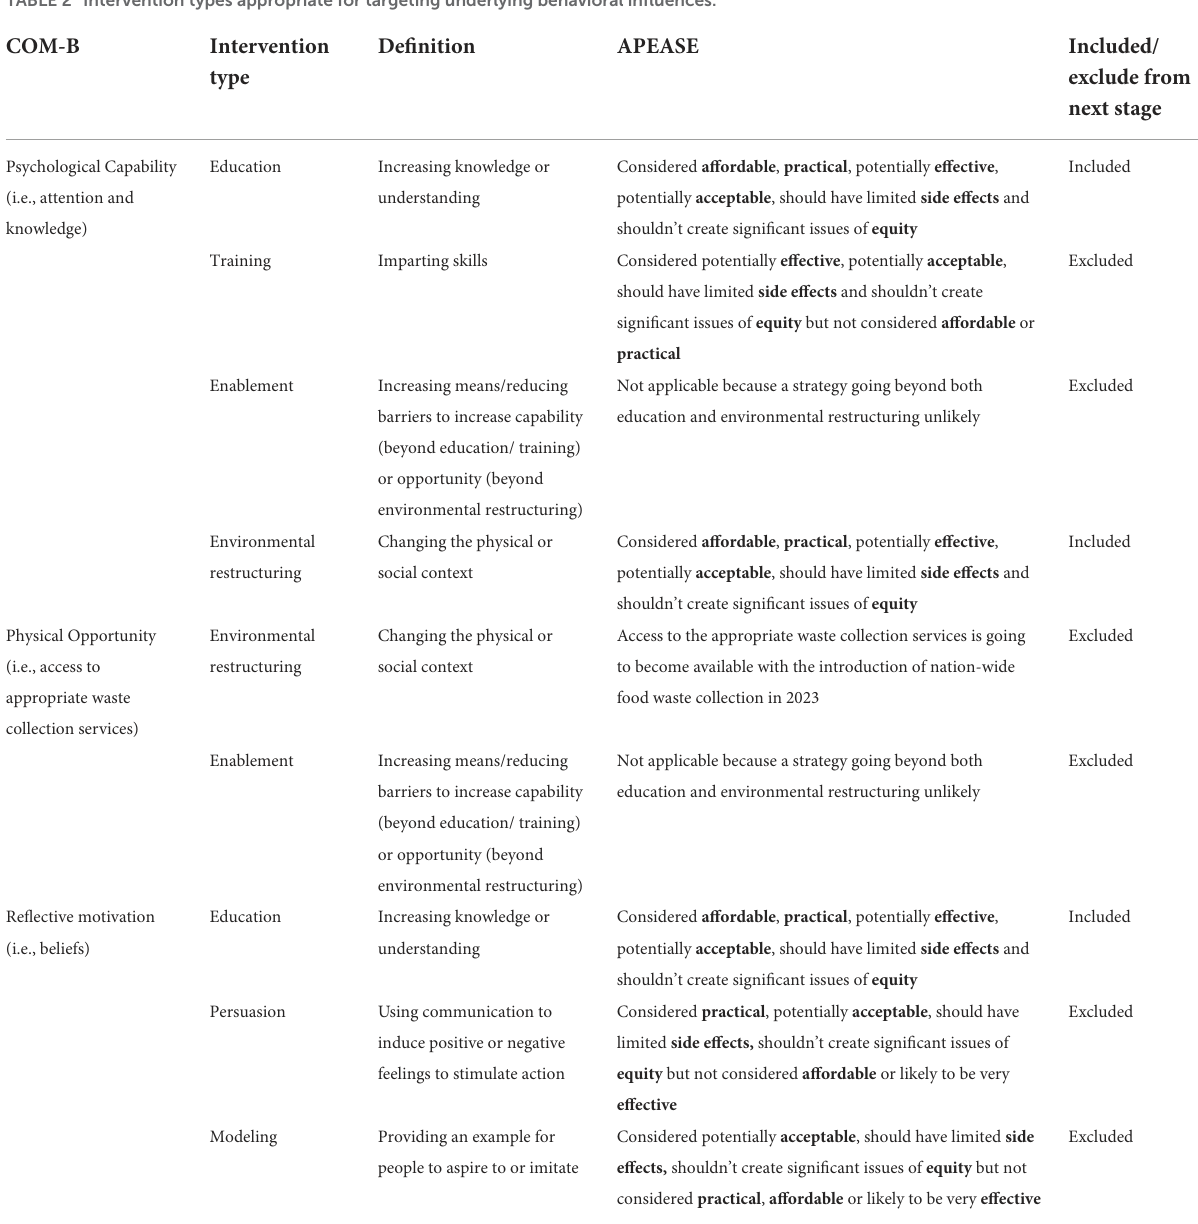
TABLE 2 Intervention types appropriate for targeting underlying behavioral